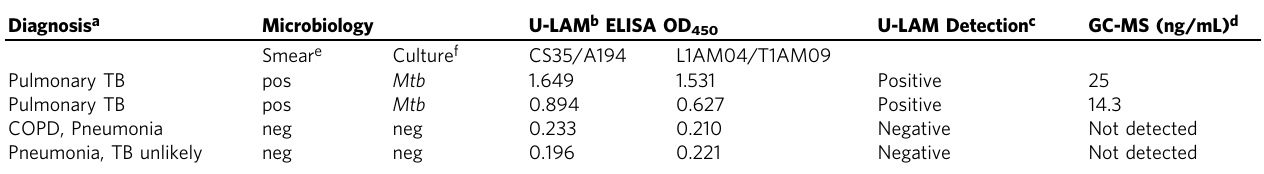
a All four patients were HIV uninfected. b Capture ELISA for the detection of LAM in urine (U-LAM). c U-LAM detection above cut-off based on background values for healthy control urine for each mAb pair by capture ELISA (OD450 0.259 for CS35/A194 mAb pair and 0.335 for L1AM04/T1AM09 mAb pair, respectively). d Quanti fi cation of U-LAM by gas chromatography-mass spectrometry (GS-MS) D-Arabinose detection method. e Sputum smear microscopy for acid fast bacilli (AFB). f Mycobacterial culture of